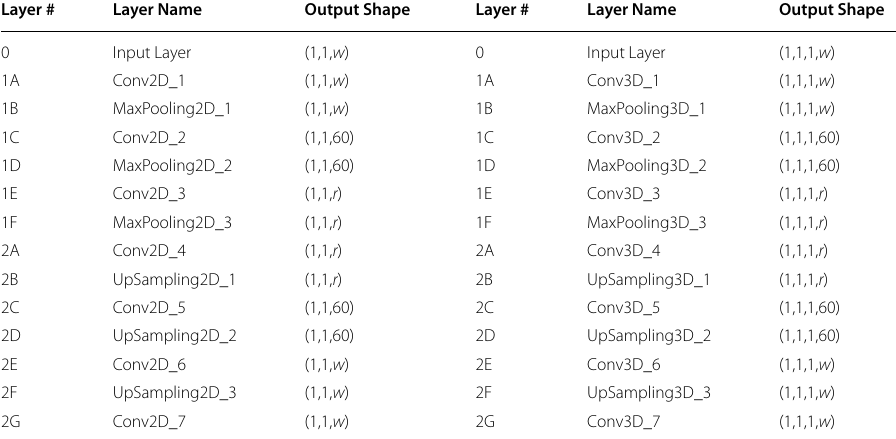
Table 11 The layer-wise summary of the 2D (left) and 3D (right) convolutional autoencoders used in experiments. w is the input spectral dimension, and r is the desired reduced spectral dimension size. Note that layer 1F in each network is the end of the encoder and 2A is the start of the decoder